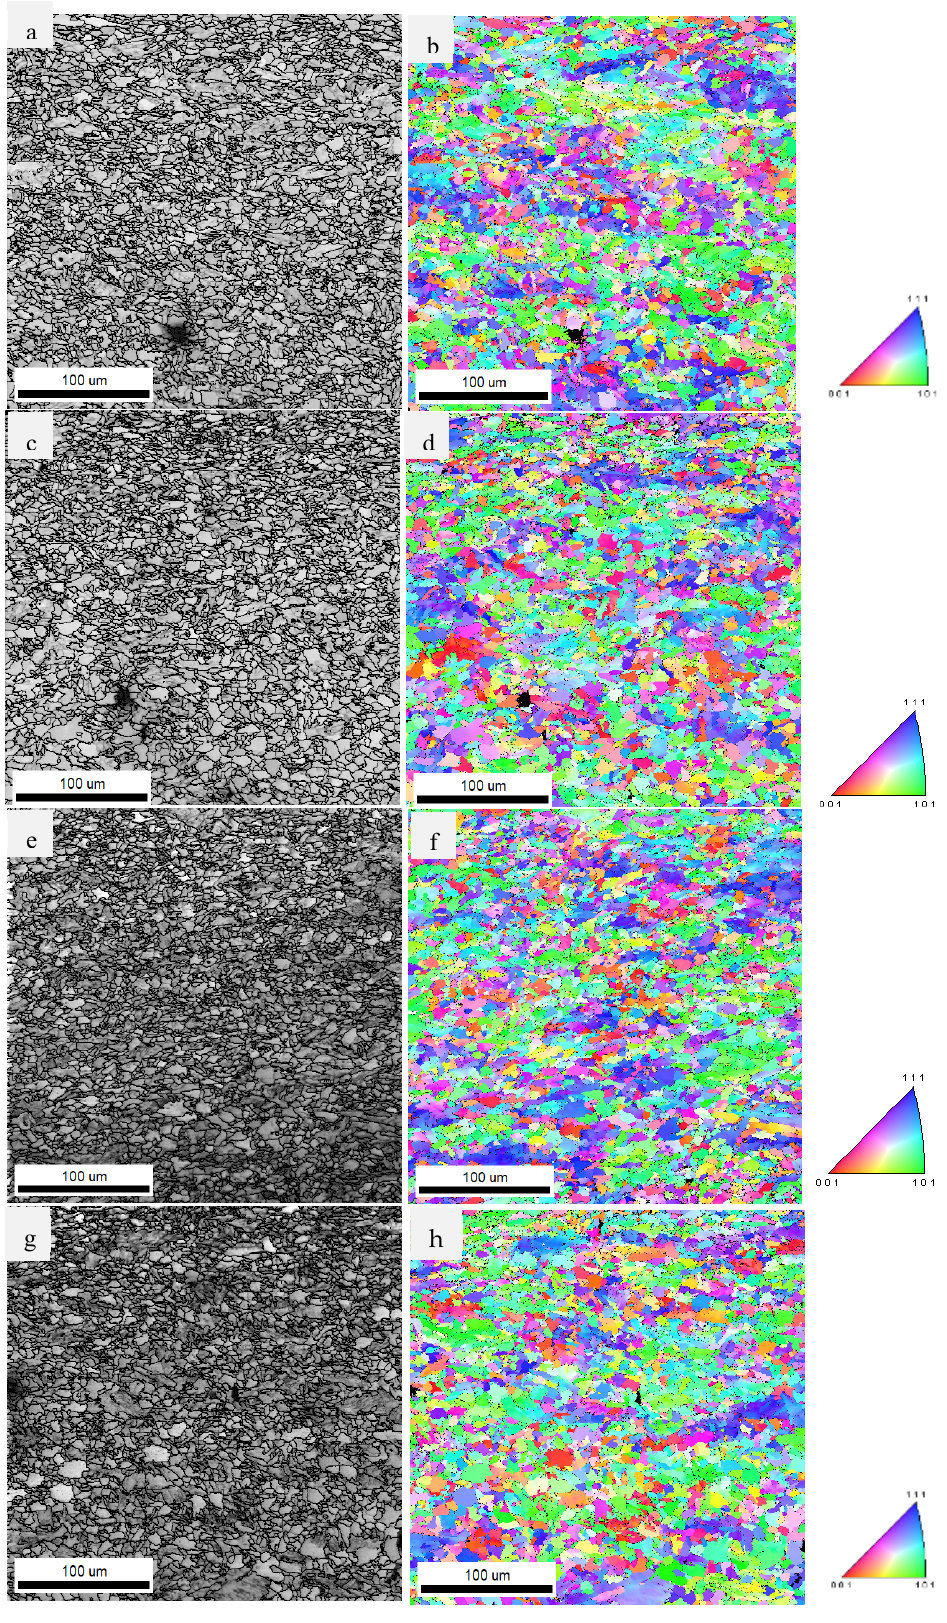
Figure 6. IQ and IPF mapping of LSPwC microalloyed steel specimen at 532 nm with ( a , b ) 3 GW/cm 2 , ( c , d ) 6 GW/cm 2 , ( e , f ) 9 GW/cm 2 , and ( g , h ) 12 GW/cm.